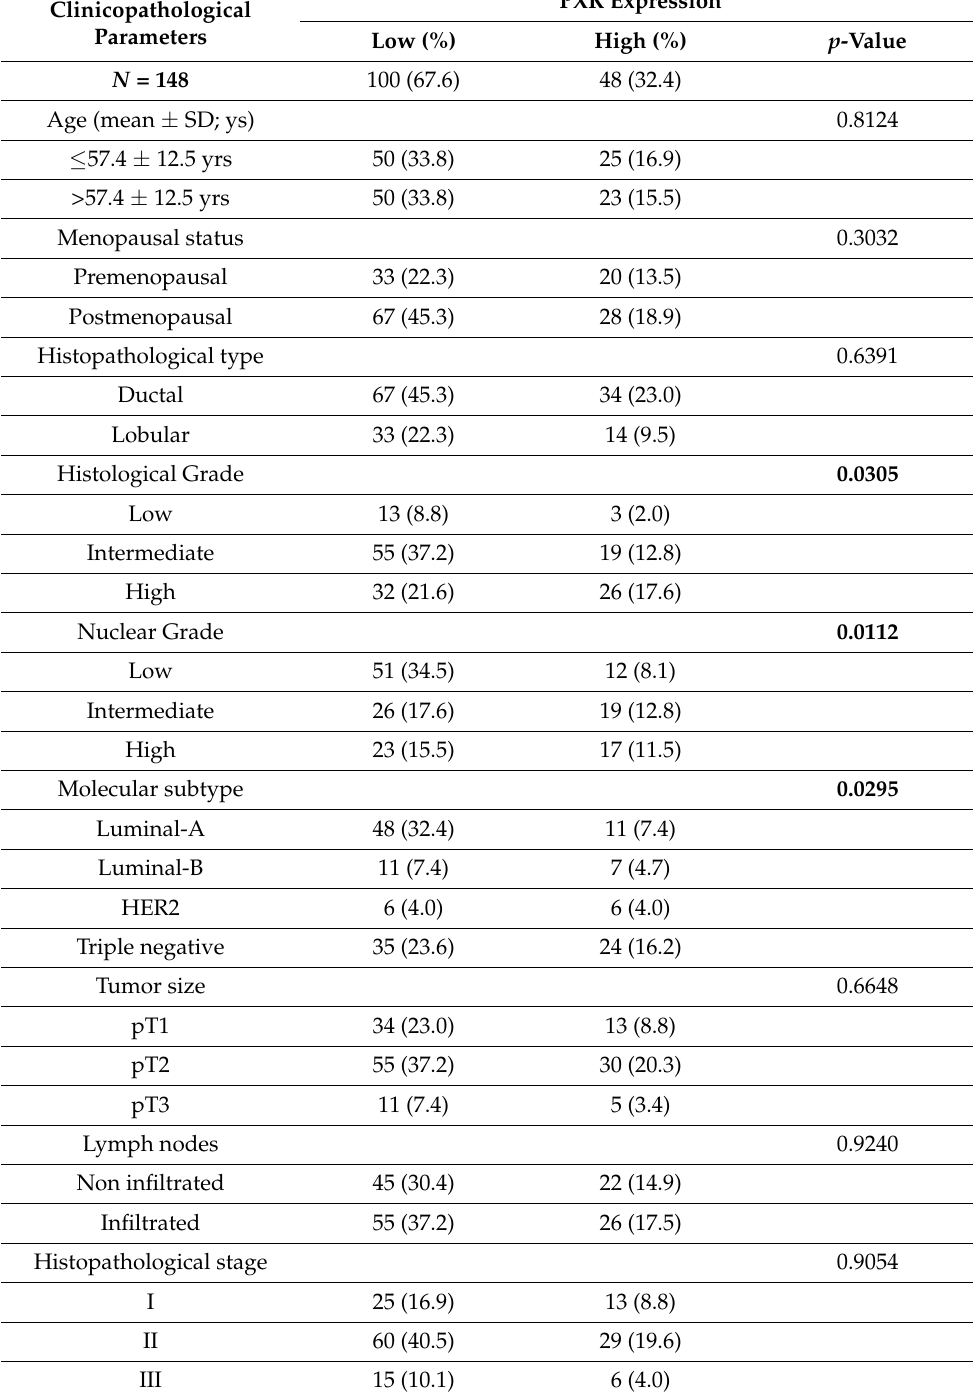
Table 1. Associations between PXR expression and clinicopathological parameters in 148 patients with invasive breast carcinoma. Statistically significant values are shown in